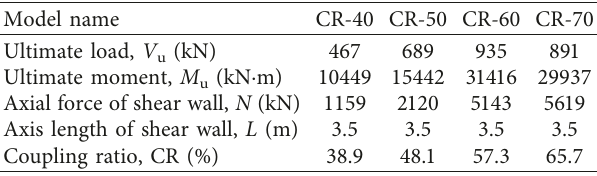
Figure 18: Mises stress distribution of full-bolt connection at ultimate displacement. Table 6: Calculation of CR from FEM